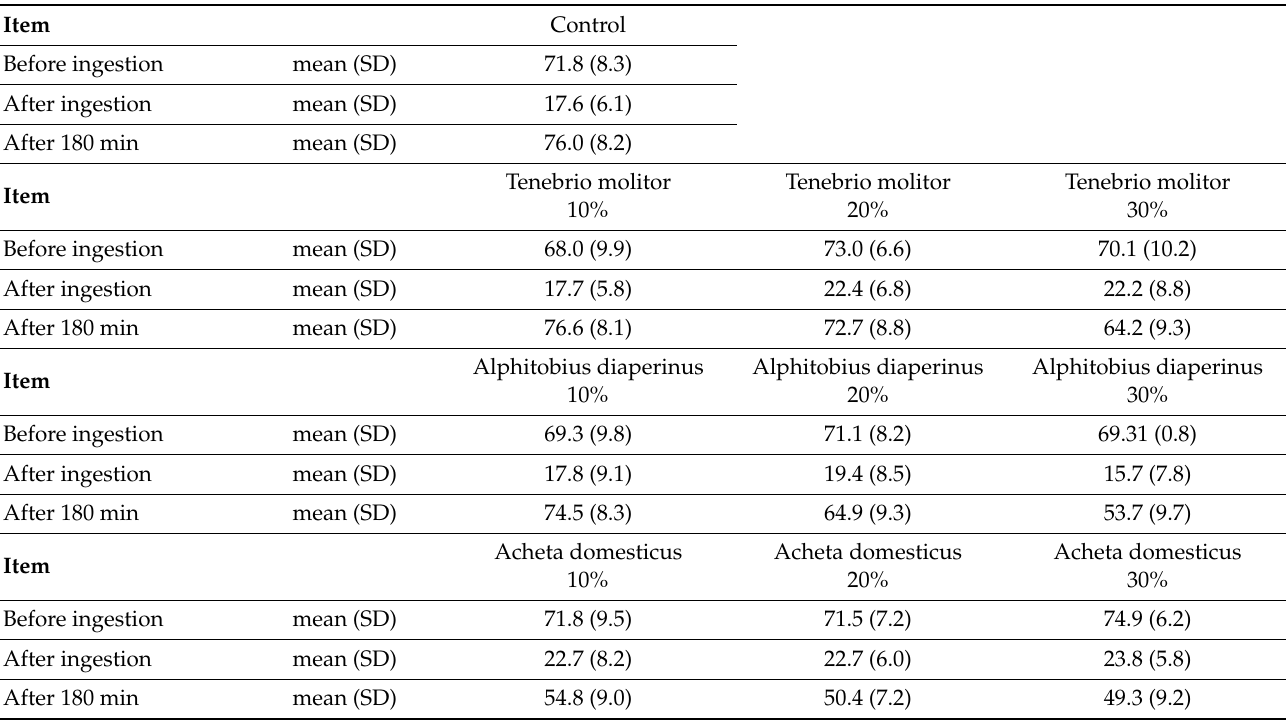
Table 3. The results of the hunger level assessment after the ingestion of test products with the addition of an insect flour for n = 71 participants.